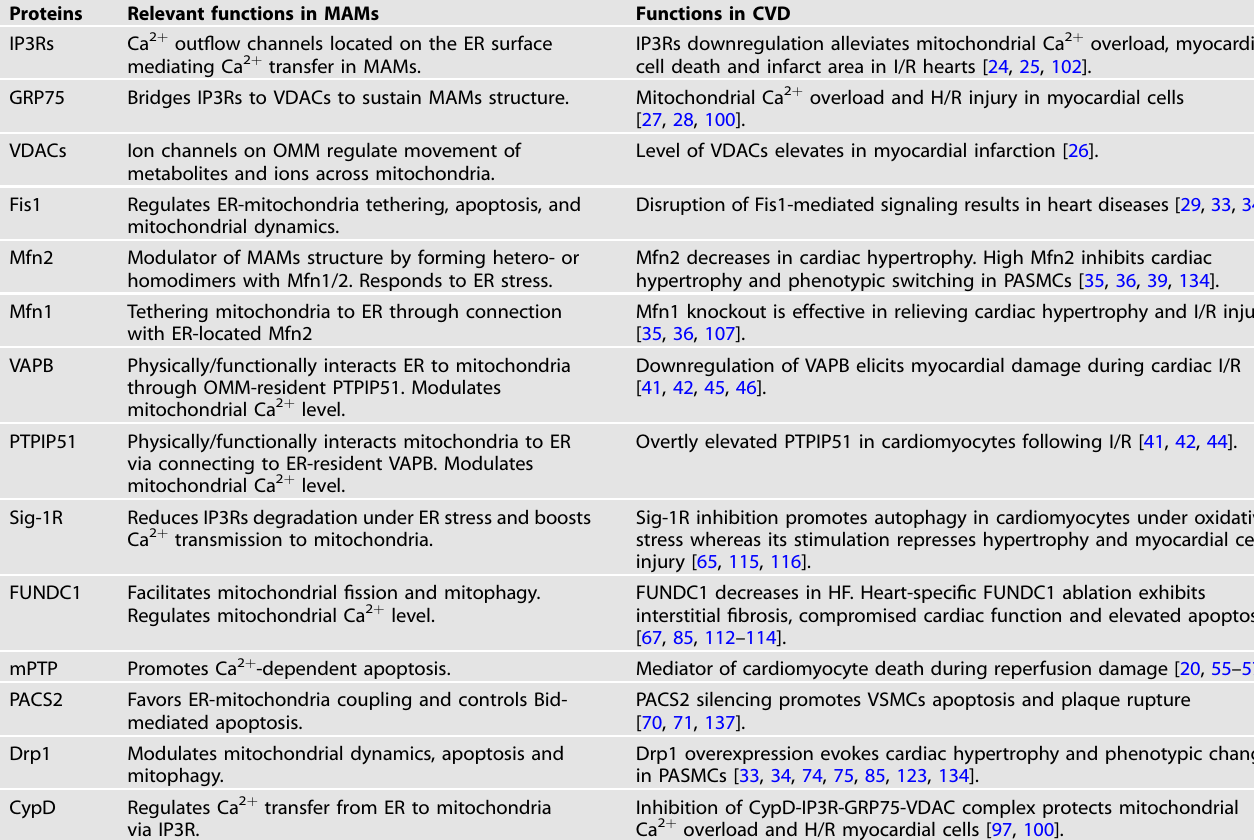
Table 1. Components of MAMs participated in cardiovascular diseases. Proteins Relevant functions in MAMs Functions in